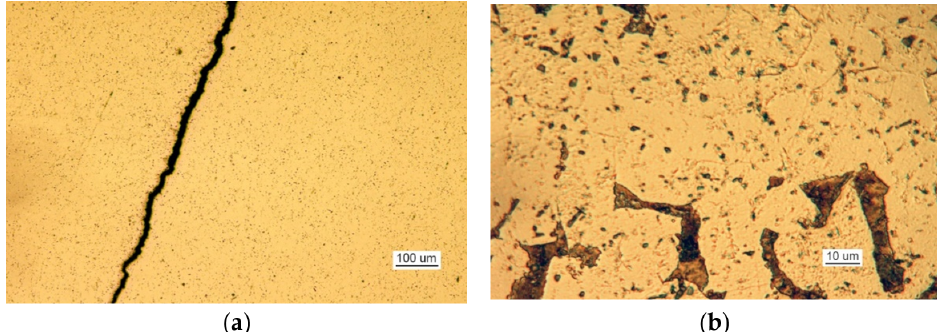
Figure 19. Optical microscopy views (handy-size bulk carrier 30206 DWT): ( a ) the crack and a very large number of spot-wise oxides and carbonitrides. Non-etched specimen; and ( b ) the ferritic and pearlitic structure of the material of element I.